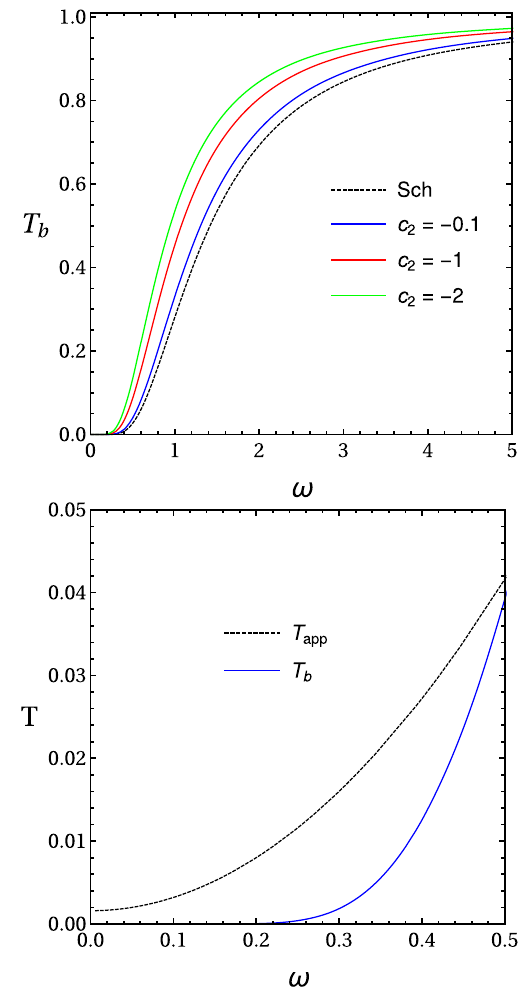
Fig. 6 The left panel shows a comparison between the rigorous bound on the greybody factor for a de Sitter black hole and a Schwarzschild black hole with (cid:18) = 0, c = 1, and ˜ M = α g = 0 . 1. The right panel shows a comparison between the rigorous bound on the greybody factor and the approximation with (cid:18) = 0, c = 1, c 2 = − 1 and ˜ M = α g = 0 .